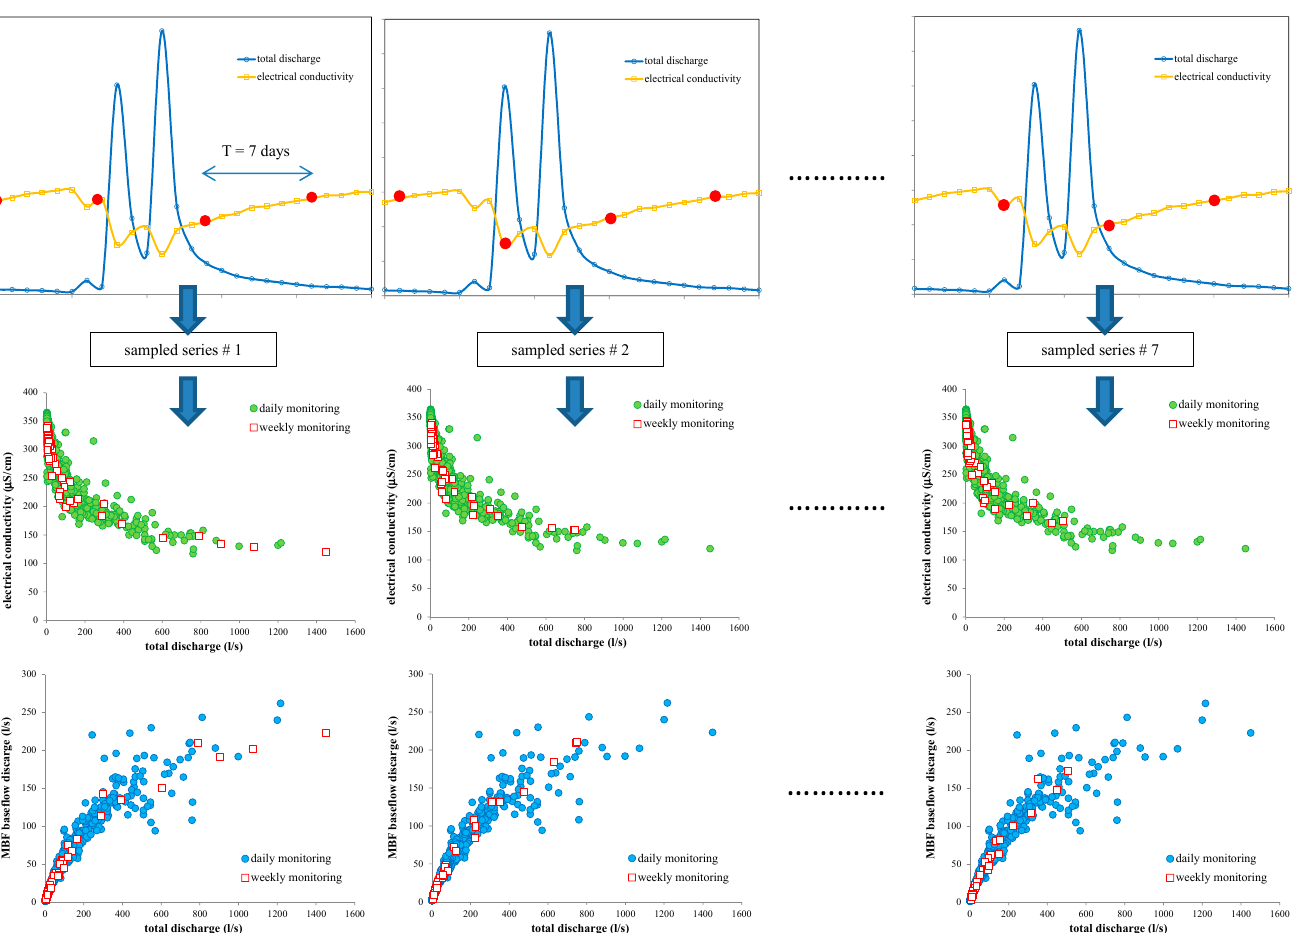
Figure 5. Fictitious weekly monitoring program. The upper panel shows total discharge and electrical conductivity patterns, and red dots represent the discontinuous monitored data. The lower panels show the associated functional relationships between EC, Q, and Q bf derived using MBF. The weekly scale monitoring functional empirical relationships overlap the daily scale functional empirical relationships for the purpose of comparison.